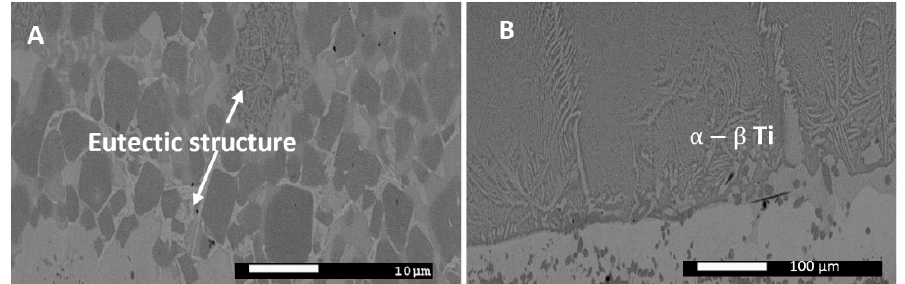
Figure 5. SEM micrographs of ( A ) the eutectic structure form at the interface for samples bonded at 900 °C; ( B ) Microstructure on the Ti side of the interface.